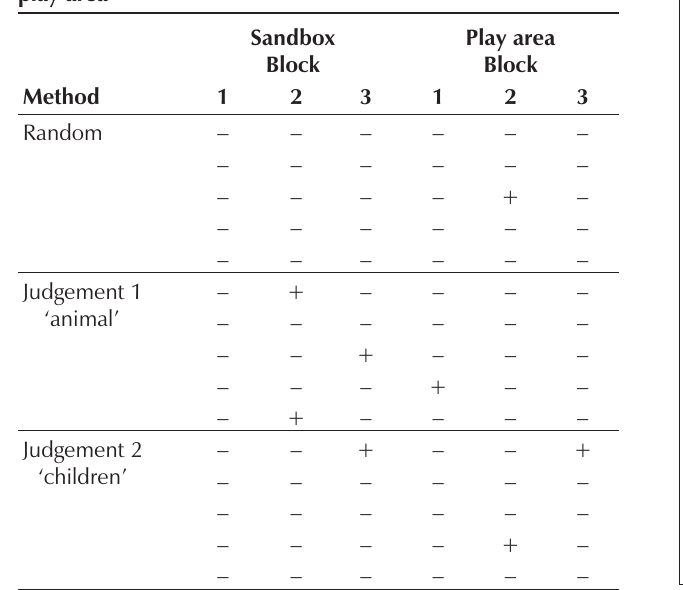
TABLE 5 Presence of Toxocara species in the study sandbox and play area